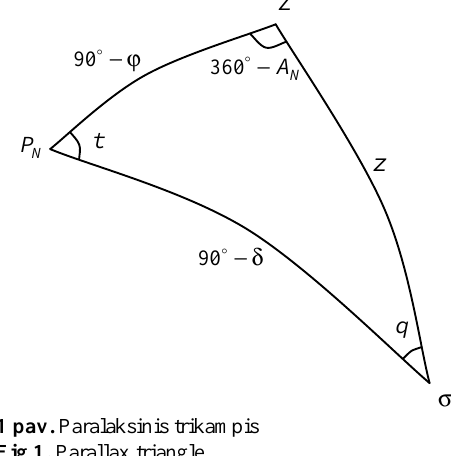
Fig 1. Parallax triangle Chronometro pataisa gaunama naudojantis laiko signal ų pri ė mimo rezultatais. Signalai priimami prieš